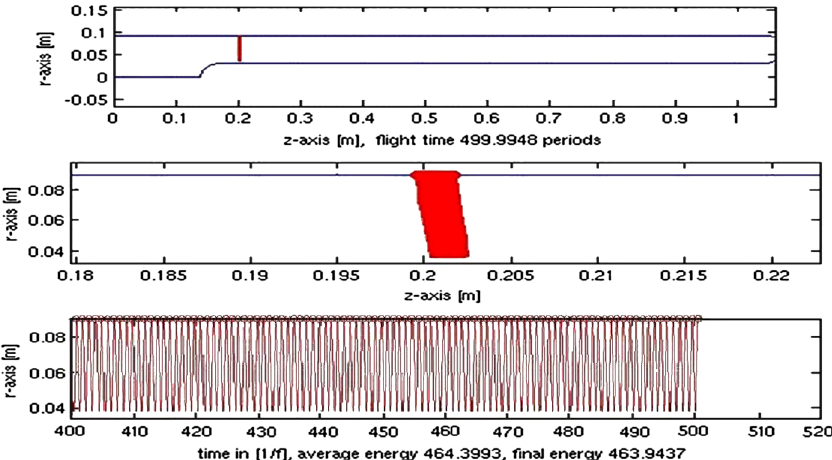
FIG. 10. (Color) The first-order one-point multipacting at peak surface electric field 71 kV = m in the 80 MHz QWR. The total number of electron impacts is 500, out of which only the last 100 impacts have been shown.